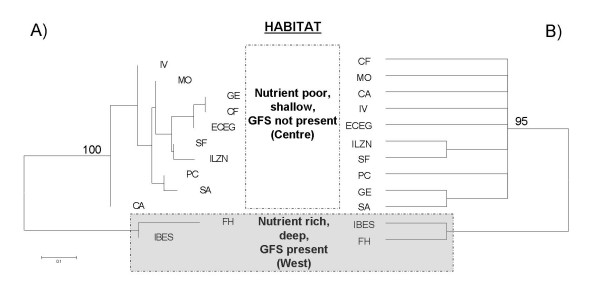
A) Neighbour-joining tree of mitochondrial DNA showing genetic relationships among rookeries of Galápagos sea lions. Genetic distances between rookeries are based on corrected mean pair-wise sequence comparisons of the mitochondrial control region. B) 50 percent Neighbour-joining bootstrap consensus tree based on Goodman's Rst at the rookery level for 22 microsatellite loci. Bootstrap support values (5000 replicates) are shown above the nodes. Abbreviations: GFS = Galápagos fur seal, letter codes represent sampled populations (see Fig. 1)